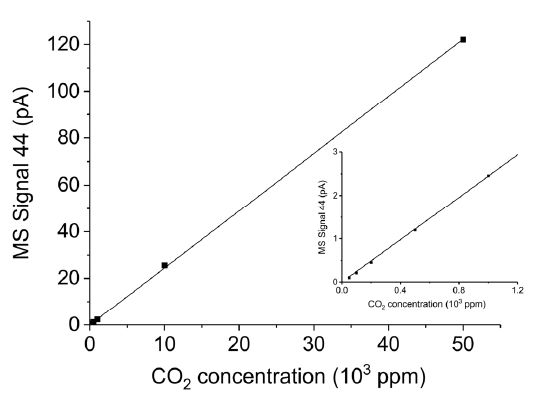
Figure A14. Mass spectrometer signal m/e = 44 for different CO 2 concentrations in Ar from 0 to 5%; inset: enhancement of the CO 2 concentration range of 0 to 1000 ppm.